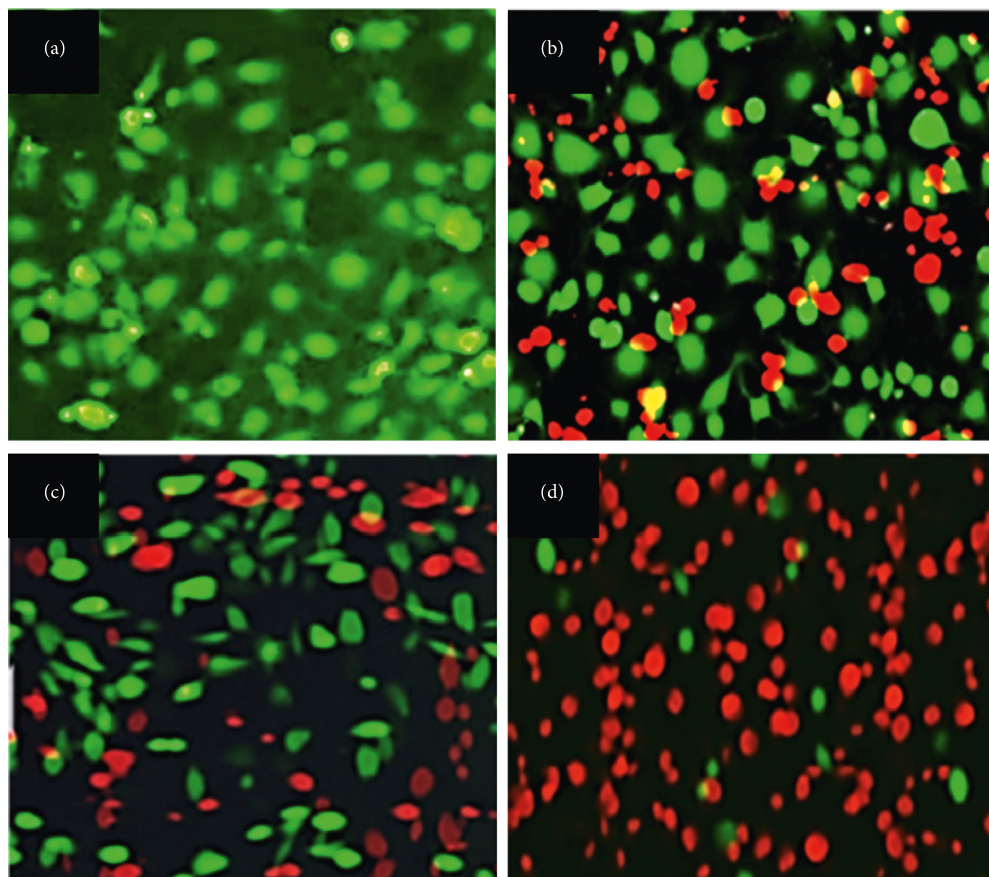
Figure 6: Anticancer activity against MCF-7 cancer cells. The green dyed cells are the live cells, while red dyed cells are the dead cells. (a) Control, (b) treated with plant extract, (c) treated with chemically synthesized Cr 2 O 3 NPs, and (d) treated with green-synthesized Cr 2 O 3 NPs [154].